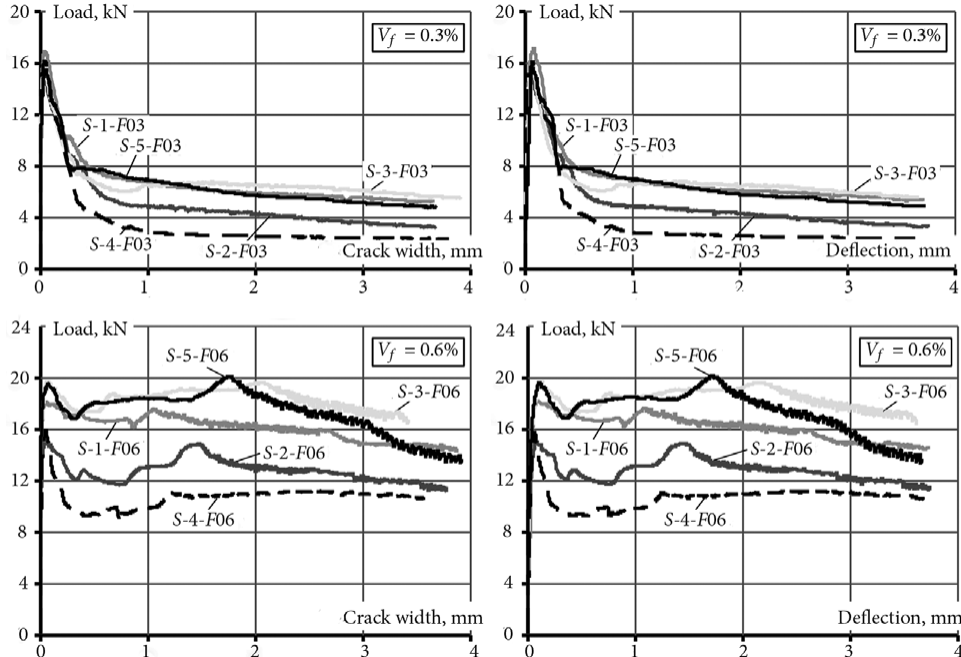
Fig. 4. Load-crack tip opening displacement and load-deflection diagrams of the beams subjected to three-point loading (Rilem test)